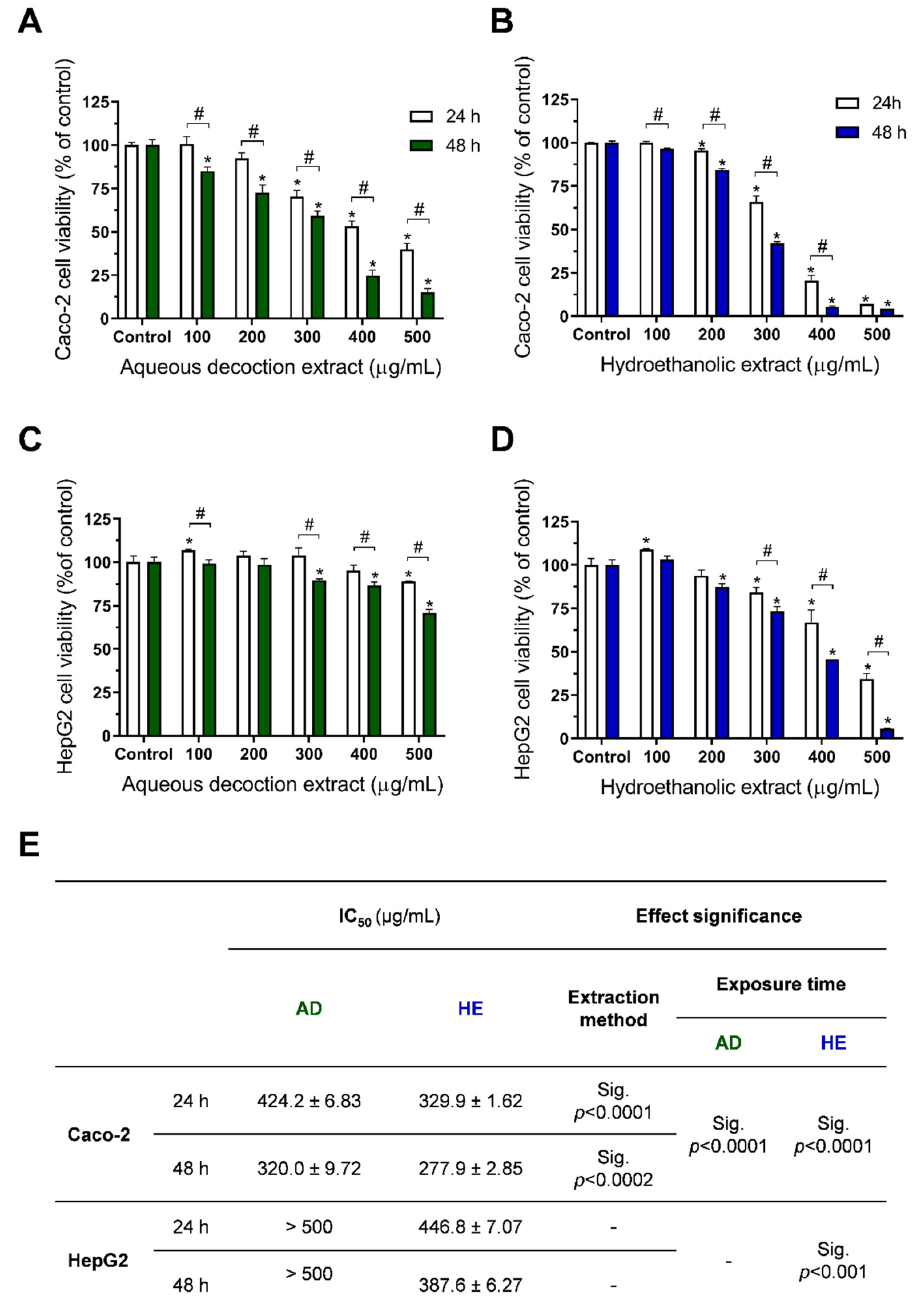
Figure 3. Thymus capitellatus aqueous ( A , C ) and hydroethanolic ( B , D ) extracts’ anti-proliferative/cytotoxic activity against Caco-2 and HepG2 cells, after 24 or 48 h of exposure (as denoted), and ( E ) IC 50 values obtained from each condition. The results are expressed as mean ± SD, n = 4. Significant statistical differences were marked as “*” when between a concentration and the respective control and “#” between the same concentration at different exposure times when p < 0.05.